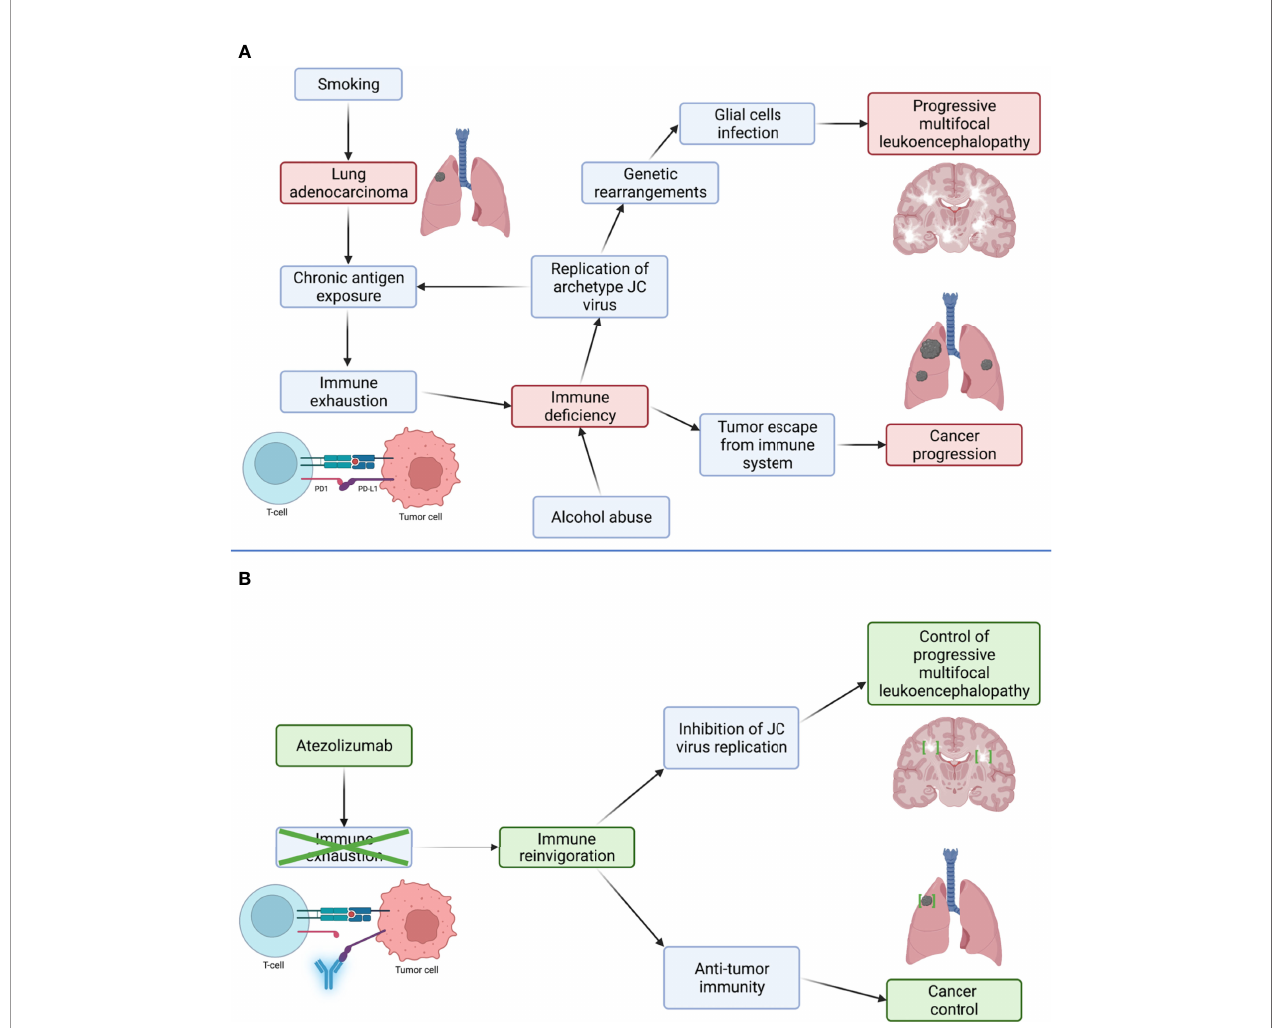
FIGURE 3 | Proposed mechanism through which control of lung adenocarcinoma and progressive multifocal leukoencephalopathy (PML) was obtained with atezolizumab. Panel (A) In basal condition, adenocarcinoma induces immune exhaustion, a phenomenon mediated by inhibitory immune checkpoints, such as PD1, and characterized by progressive loss of immune cells effector functions. Resulting immune de fi ciency allows tumor escape from the immune system leading to its progression, but also replication of archetype JC virus (JCV). JCV accumulates replication-driven genetic rearrangements, conferring it the ability to infect glial cells and cause PML. Panel (B) Anti-PD-L1 antibody atezolizumab disrupts the interaction between PD1 and its ligand, PD-L1, mediating immune exhaustion. This disruption leads to immune cells reinvigoration, permitting the immune system to regain control of both lung adenocarcinoma and JCV replication and, therefore, control of